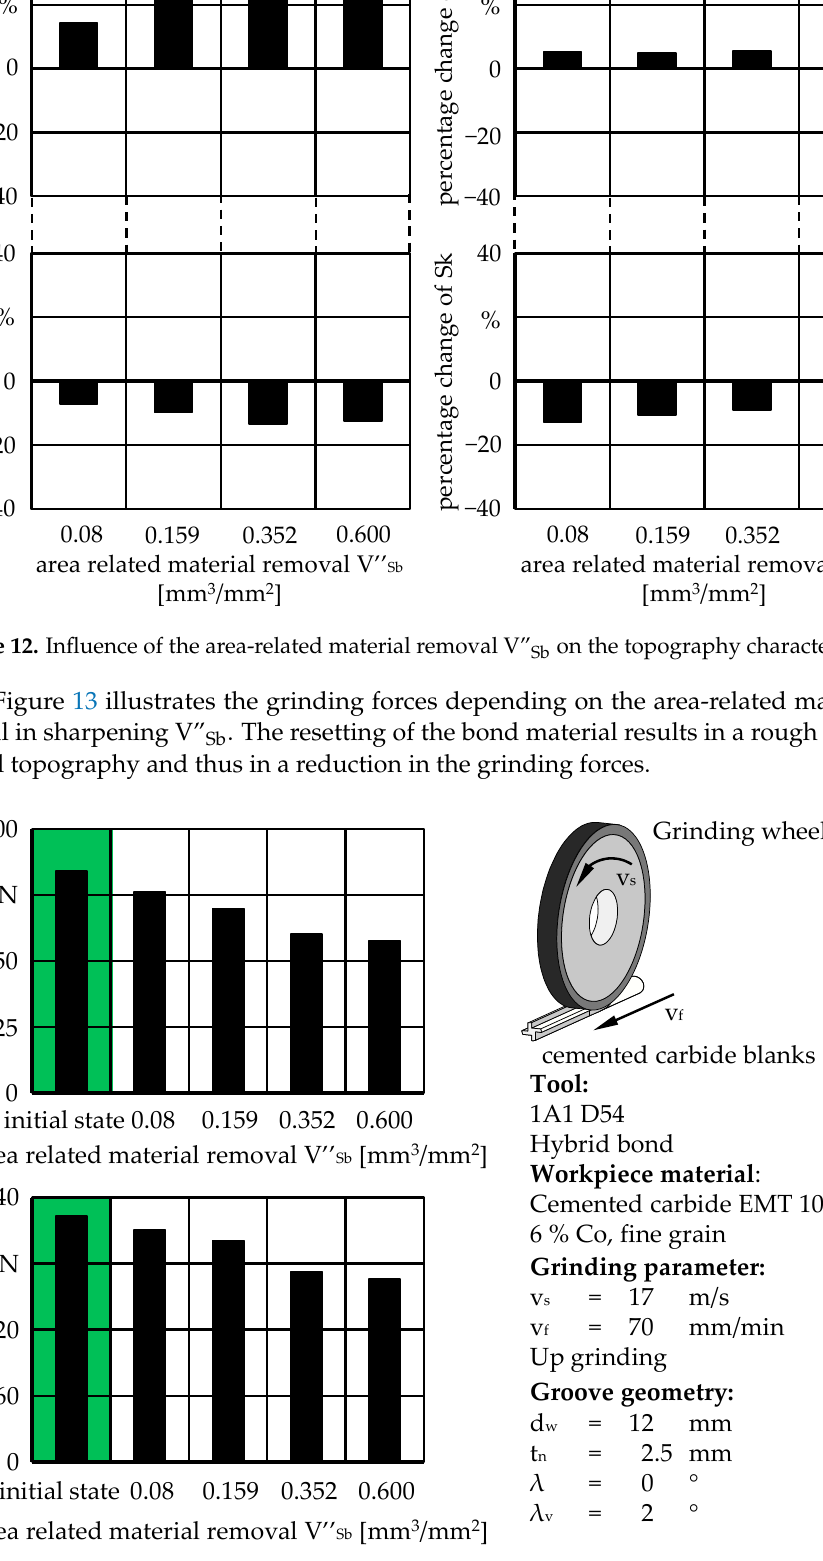
Figure 13. Influence of the area-related material removal V’’ Sb on the grinding forces.